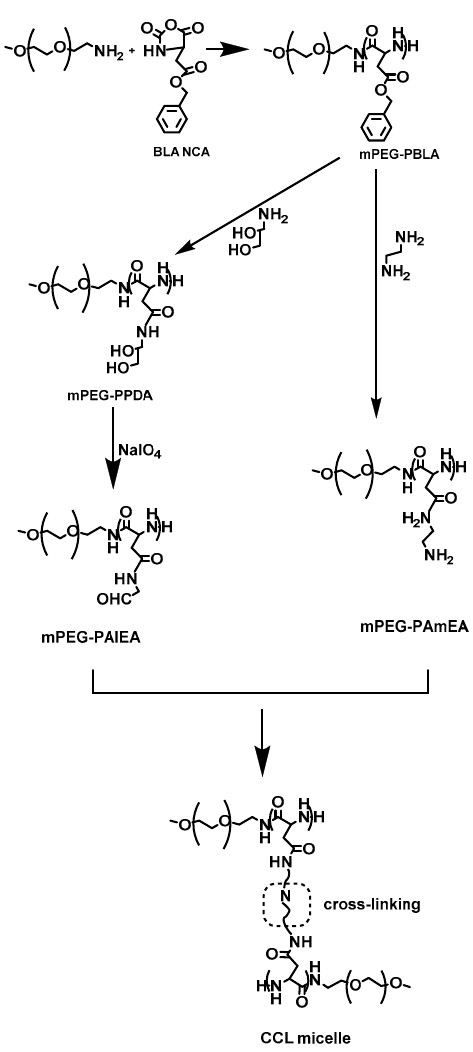
Figure 6. Synthesis of mPEG–PAmEA, mPEG–PAlEA and core-crosslinked mPEG–PA micelles.